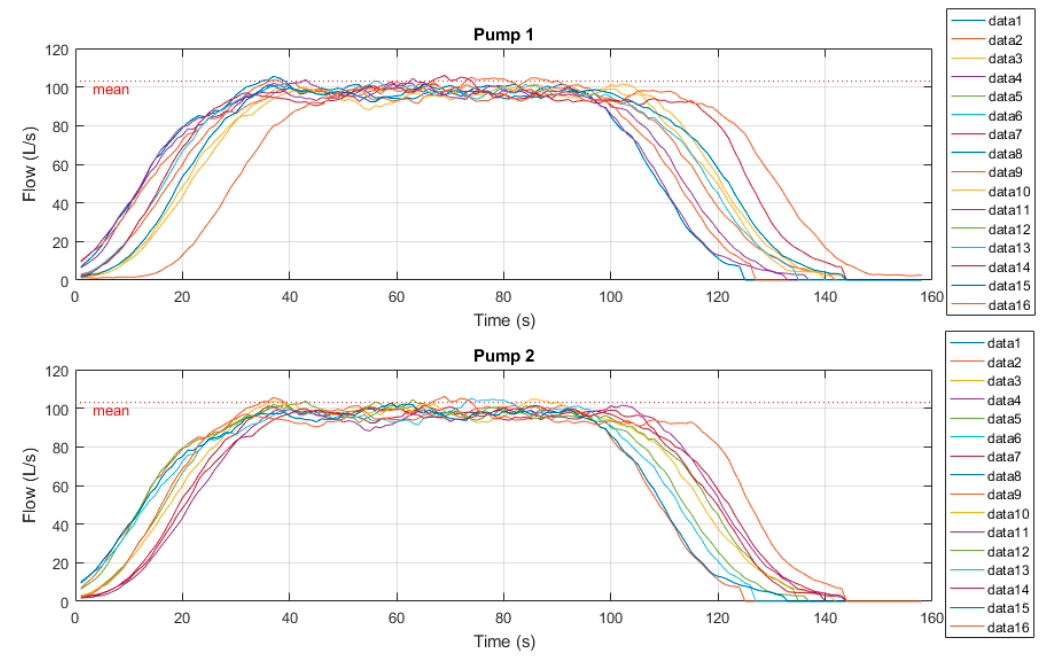
Figure 13. Site B time series radar plots.